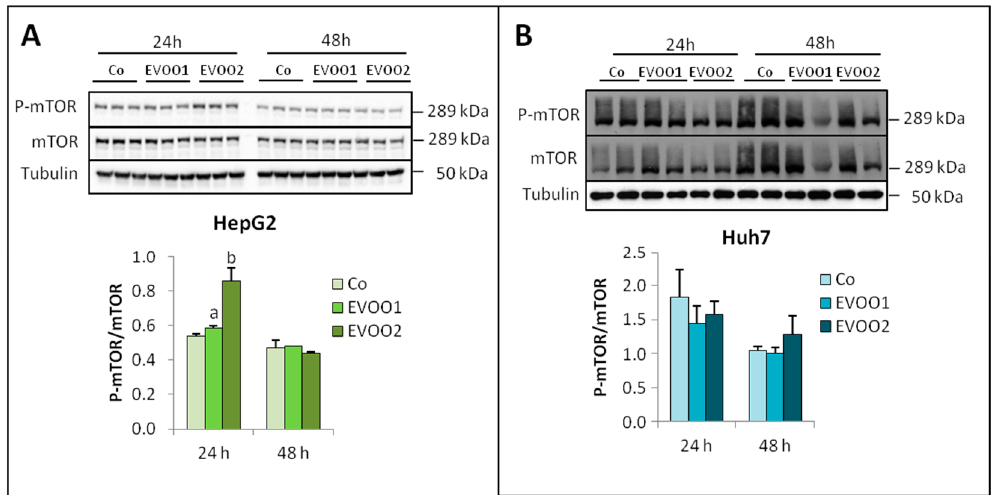
Figure 5. Phenolic extract modulates P-mTOR in HepG2 cell. ( A ) Expression of P-mTOR in HepG2 cell. ( B ) Expression of P-mTOR in Huh7 cell line. The cells were incubated for 24 and 48 h with two different doses of the EVOO extract. The results are representative of three experiments. The protein molecular weights are reported. Data are presented as mean ± SD. (a: p < 0.05, c: p < 0.001 versus Control). Phosphorylated p70 (P-p70) increased in the presence of EVOO extract in both HepG2 (24 h and 48 h; Figure 6A) and Huh7 cells (48 h, EVOO2 only; Figure 6B). As for phosphorylated 4E-BP1 (P-4E-BP1), it was unchanged in HepG2 cells while it decreased significantly in Huh7 cultures at both 24 h (EVOO2) and 48 h (EVOO1 and EVOO2; Figure 6C,D).